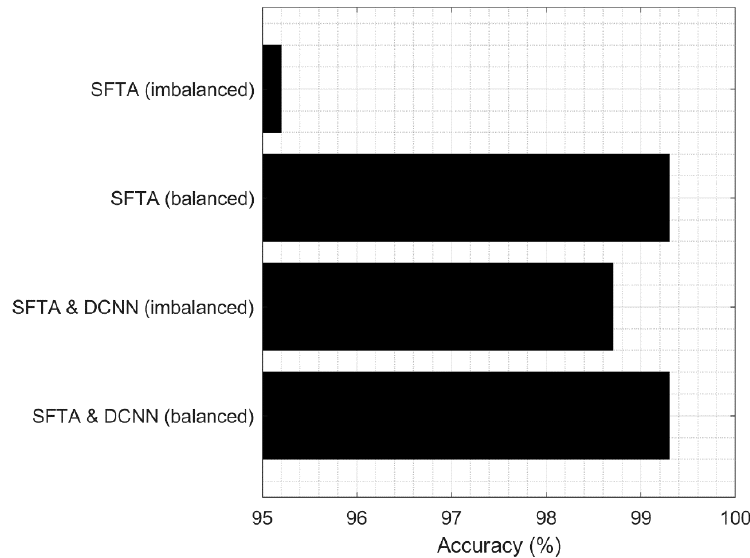
Figure 16. Comparison of best accuracy for malware classification for different feature sets (SFTA features vs a fusion of SFTA and neural network features) and imbalanced/balanced datasets.